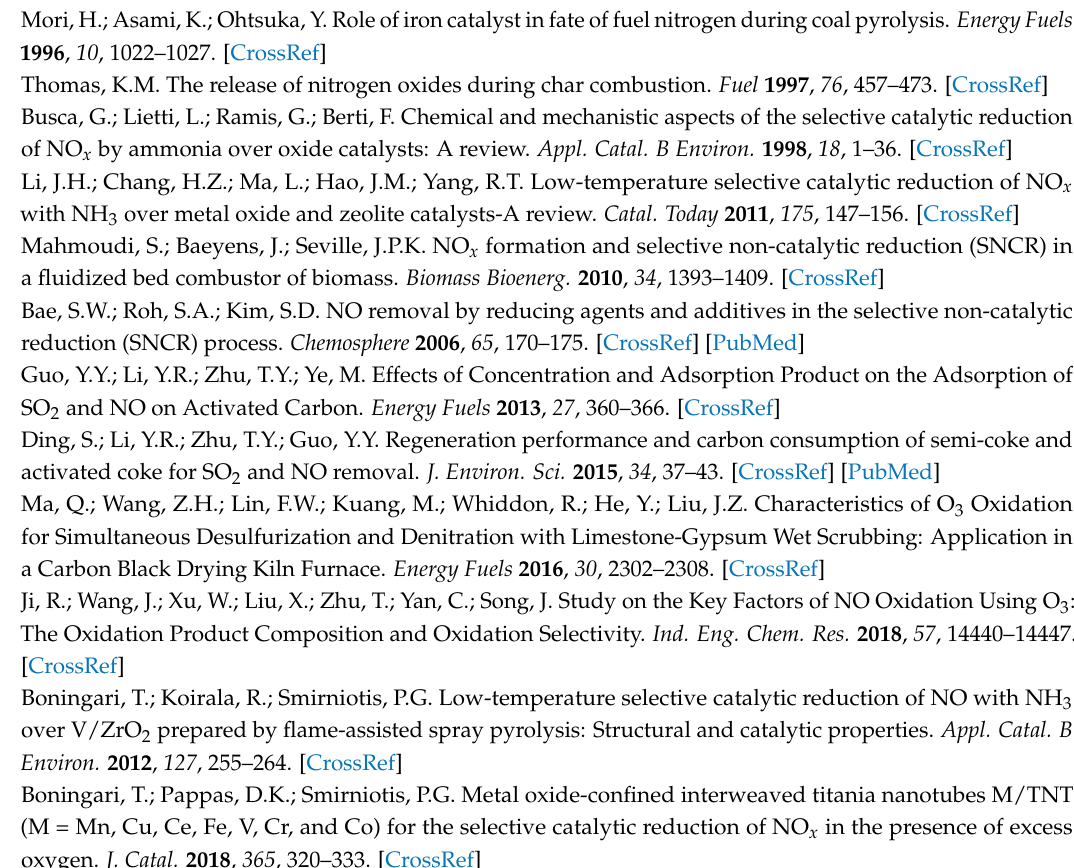
Figure S1: Alumina calcining process flow chart, Figure S2: Evaluation of different oxygen concentration of 1V/Ti catalyst, Table S1: Surface areas of various